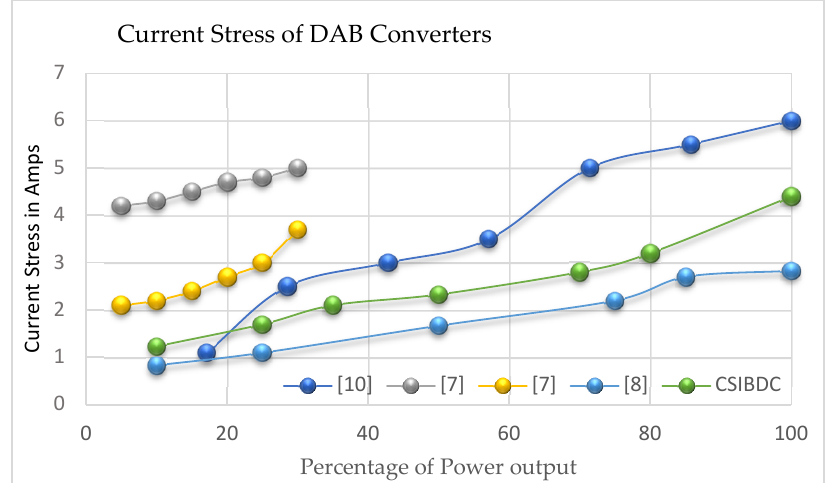
Figure 17. Comparison of current stress of various dual active bridge converters with CFIBDC con- verter.